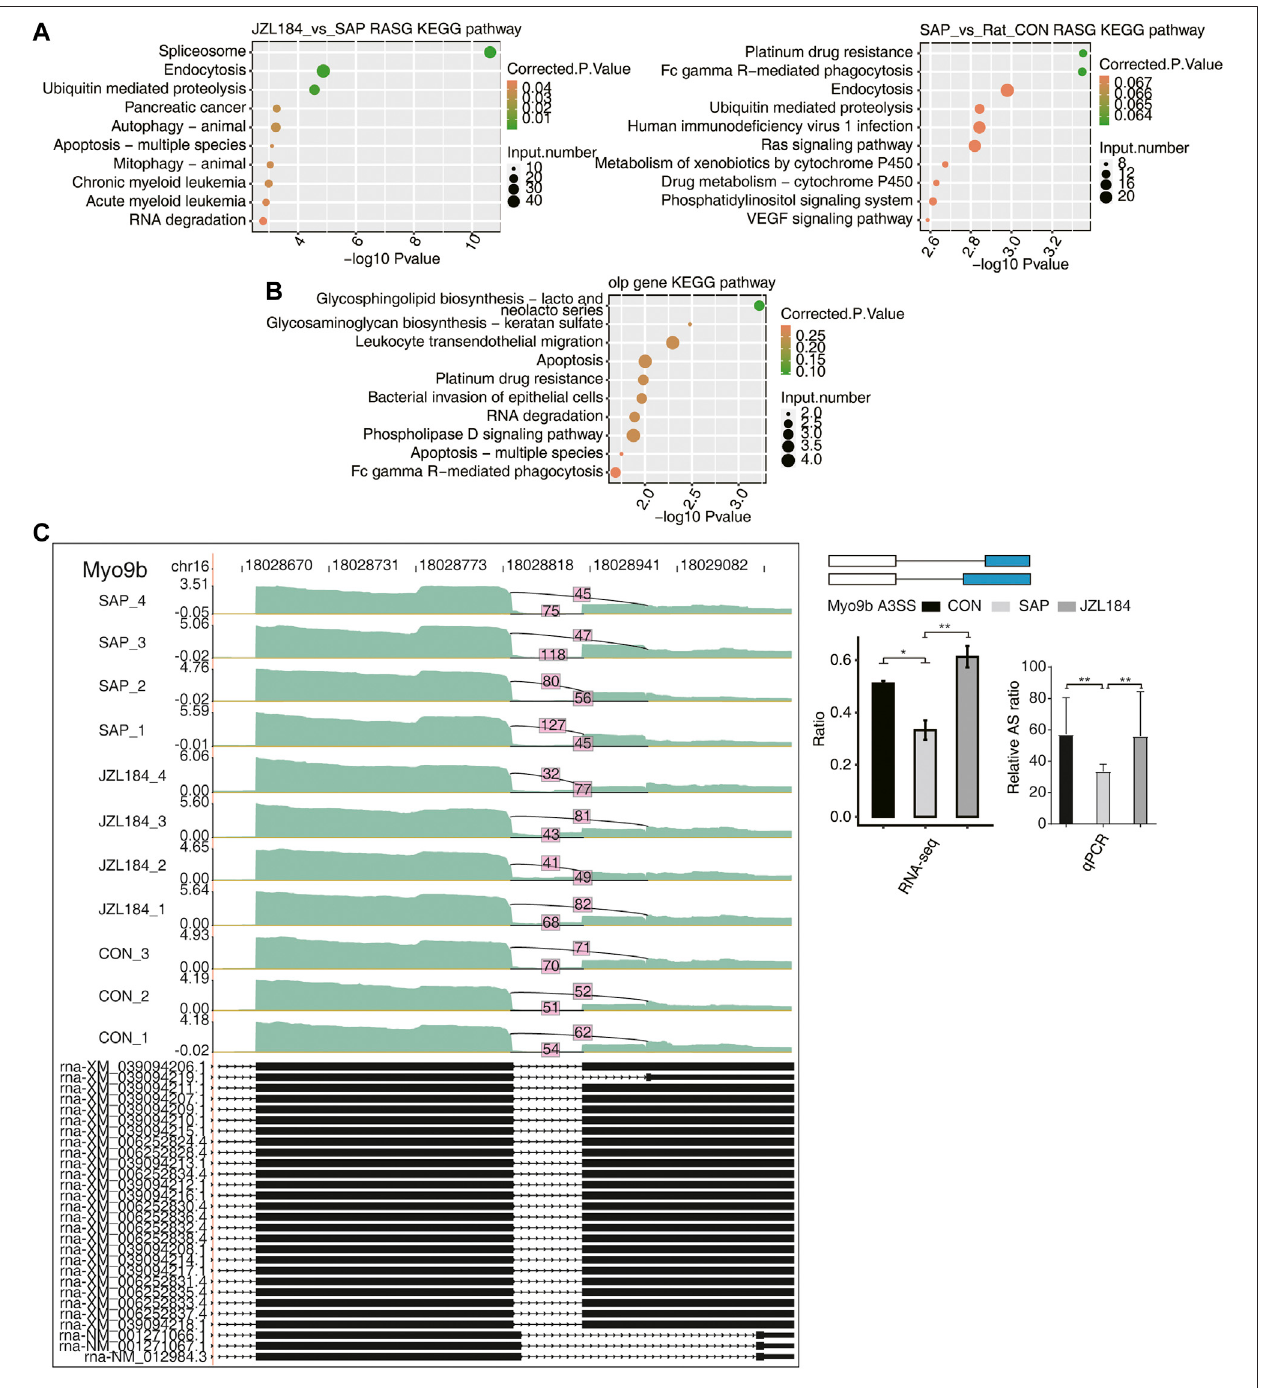
FIGURE 5 | Function analysis of MAGL inhibitor regulated alternative genes in intestinal tissue of rats with SAP. (A) Bubble plot showing enriched KEGG analysis plots of RASE. The differential ASEs were mainly enriched in platinum resistance, FC- γ R-mediated phagocytosis, endocytosis, ubiquitin-mediated proteolysis, human immunode fi ciencyvirus1infection,Rassignalingpathway,cytochromeP450metabolismofexogenousdrugs,drugmetabolismcytochromeP450,phosphatidylinositol signaling system, and the VEGF signaling pathway between the SAP and control groups; AS genes were mainly enriched in splicing, endocytosis, ubiquitin- mediatedproteolysis,pancreaticcancer,animalautophagy,apoptosisofmanyspecies,animalmitochondrialautophagy,chronicmyelogenousleukemia,acutemyeloid leukemia, RNA degradation, and other functional pathways between the JZL184 and SAP groups; (B) Bubble plot showing enriched KEGG analysis of the genes with overlappedsheareventsintheoppositedirectionobtainedbythetwocomparisongroups; (C) MAGLregulatesalternativesplicingofMyo9b.Leftpanel:IGV-sashimiplot showing the regulated alternative splicing events and binding sites across mRNA. Reads distribution of RASE is plotted in the up panel and the transcripts of each gene areshownbelow.Rightpanel:TheschematicdiagramsdepictthestructuresofASEs.RNA-seq validationofASEsareshown atthebottomoftherightpanel. Errorbars represent mean ± SEM. *** p -value < 0.001, ** p -value < 0.01, * p -value < 0.05. n = 3 in control group. n = 4 in SAP group and JZL184 group.